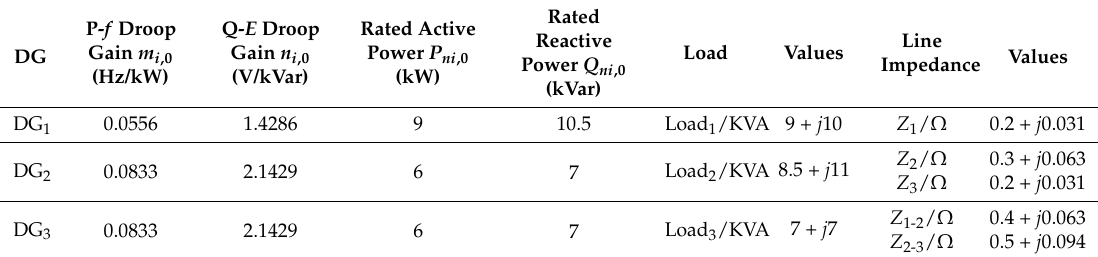
Table 1. Parameters of the